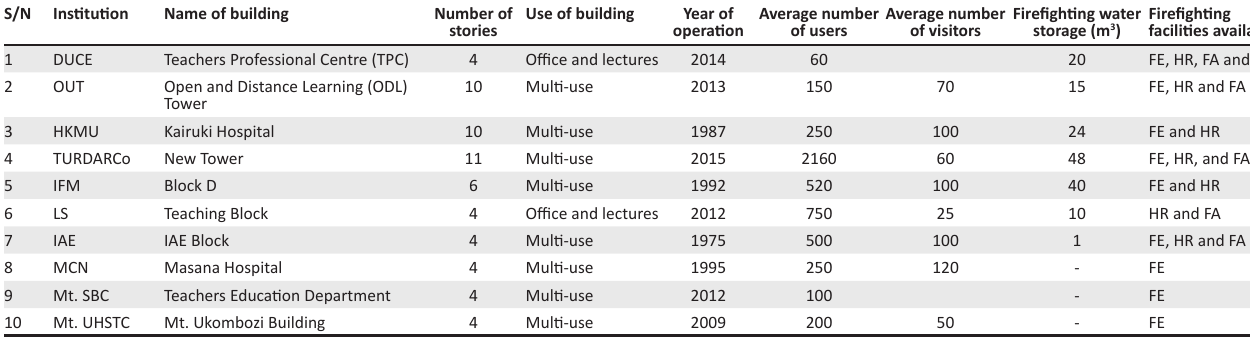
TABLE 3: Information about the selected buildings.